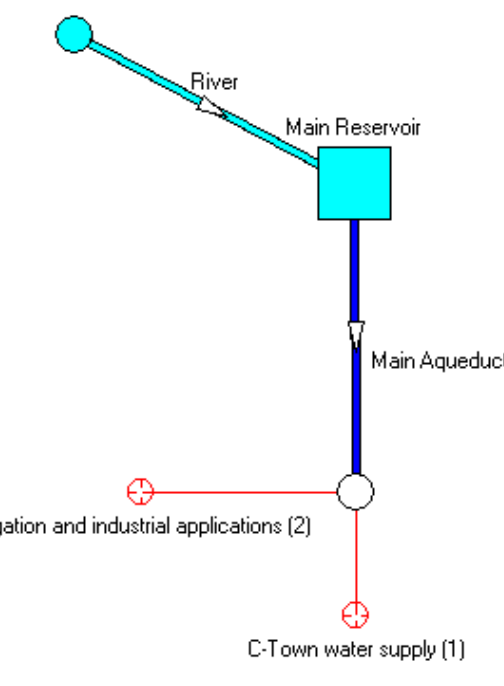
Figure 6. The water supply system of the UWS.